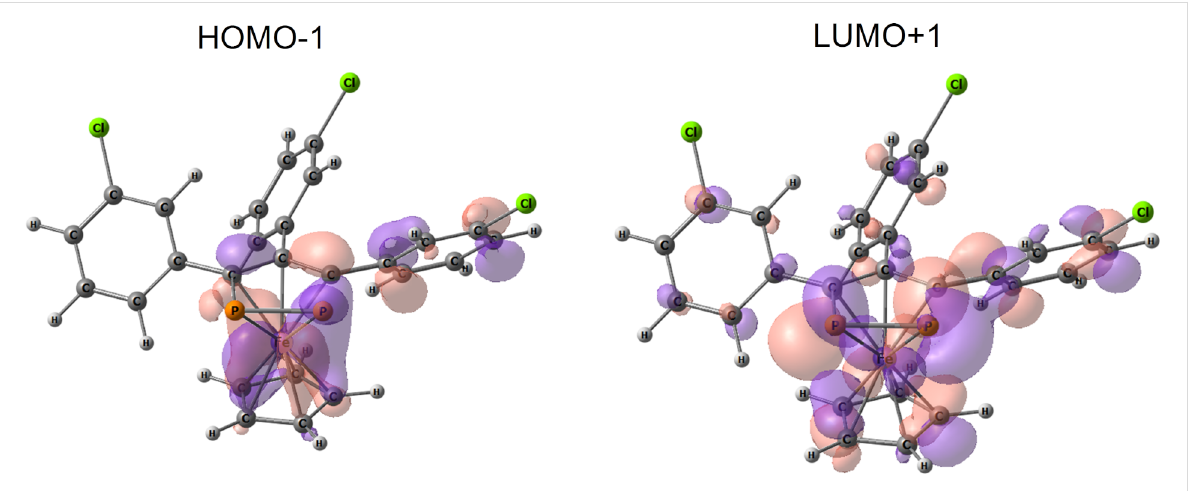
Figure 4: Frontier orbitals of 8b - II contributing to absorption bands at about 380 nm.